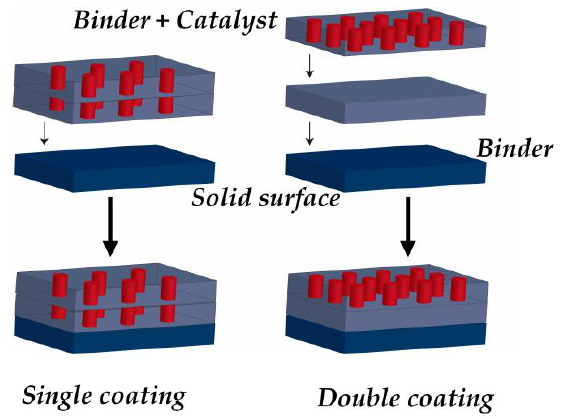
Figure 1. Preparation of single and double layer coating.